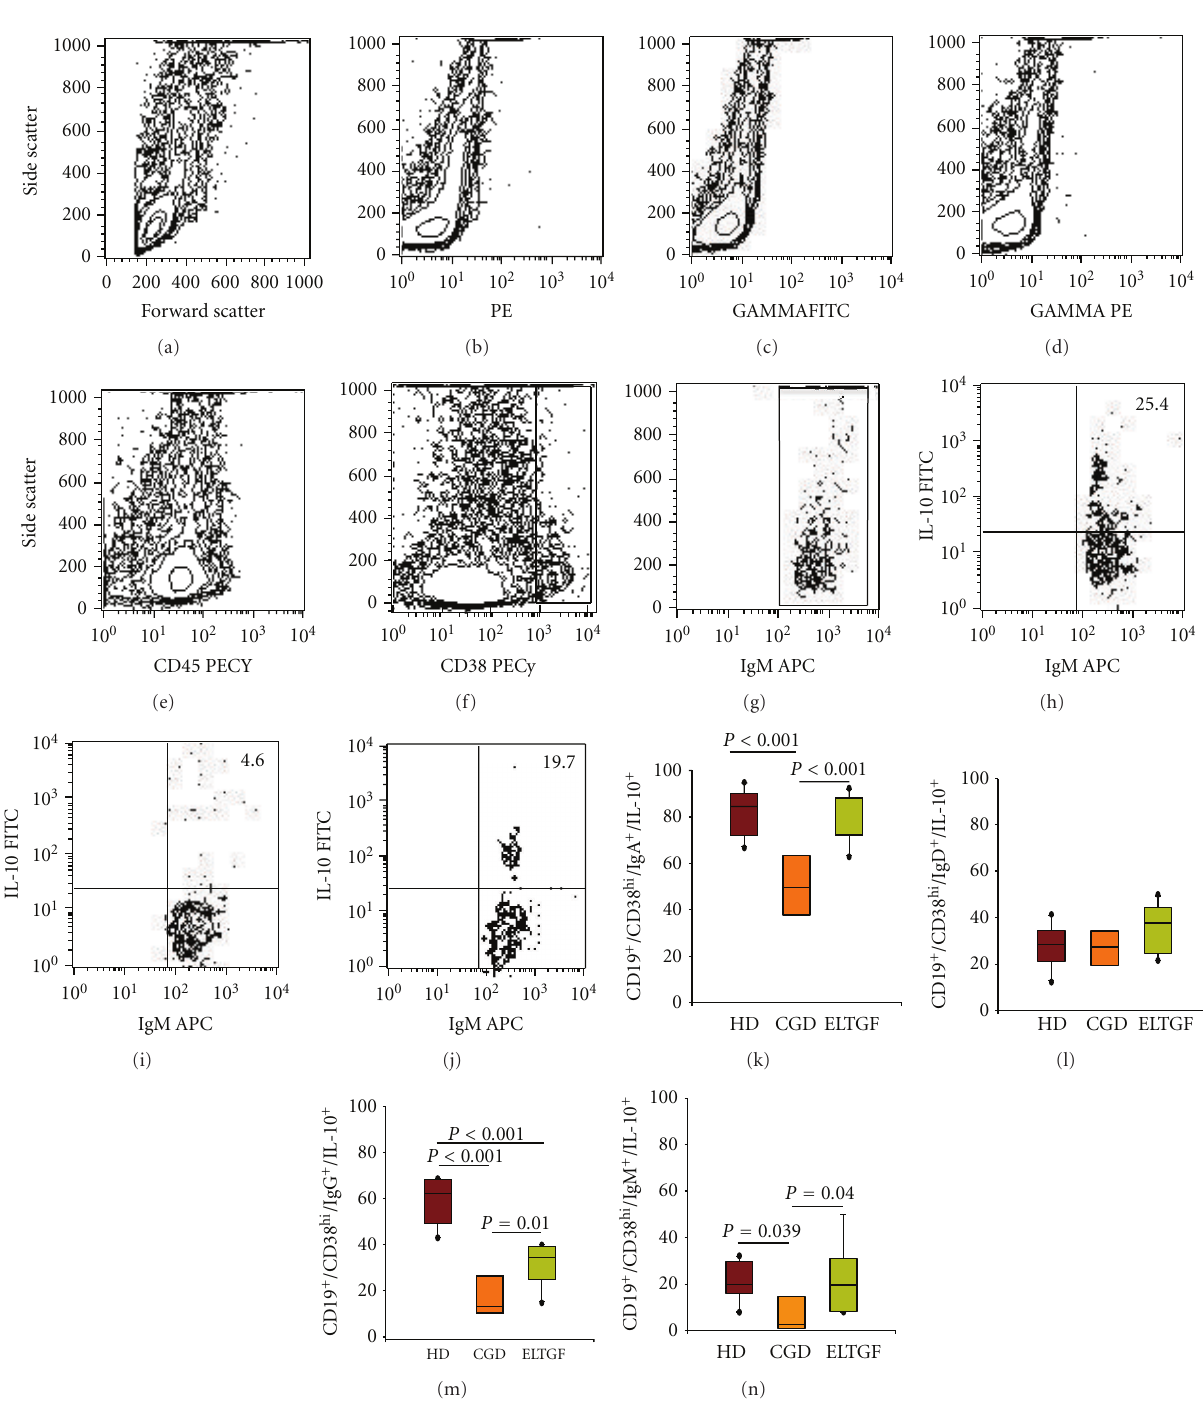
Figure 2: Percentage of immunoglobulin expression on IL-10-producing B peripheral cell subtype in KTR. (a) Autofluorescence control. (b) PE-conjugated-anti-rat-IL-10 IgG isotype control. (c–e) IgG 1 -FITC/IgG 1 -PE/CD45-PeCy5 mouse IgG 1 ,k isotype controls. (f) Representative contour plot of CD19 + B cells from a patient. An electronic gate was made for CD38 hi cells. (g) From the gate f CD19 + /CD38 hi /IgM + cells were determined. From the latter CD19 + /CD38 hi /IgM + /IL-10 + , cells were defined in (h) a healthy donor (HD), (i) a chronic graft dysfunction (CGD) patient, and (j) an excellent long-term graft function under immunosuppression (ELTGF) patient. A total of 30,000–50,000 events were recorded for each sample before any gate setting and analyzed with the CellQuest Pro software (BD Biosciences). Bar graphs show percentage of (k) IgA + , (l) IgD + , (m) IgG + , and (n) CD19 + /CD38 hi / IL-10 + /IgM + cells. Results are expressed as median, 10th, 25th, 75th, and 90th